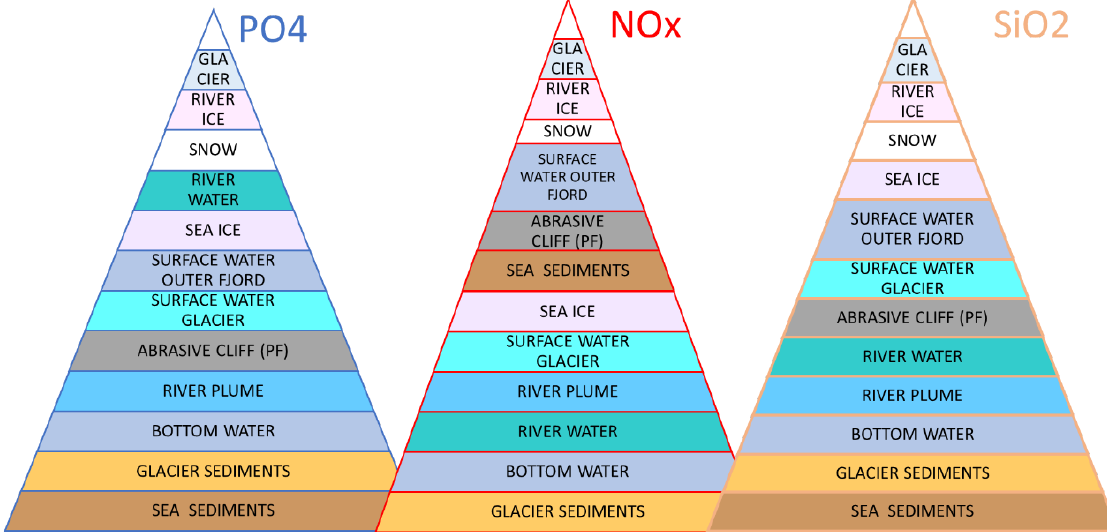
Figure 8. Hierarchical change of concentrations of phosphate, nitrate, and silicate in the following environmental media: seawater, bottom sediments, river water, sea ice, river ice, glacier ice, and snow.